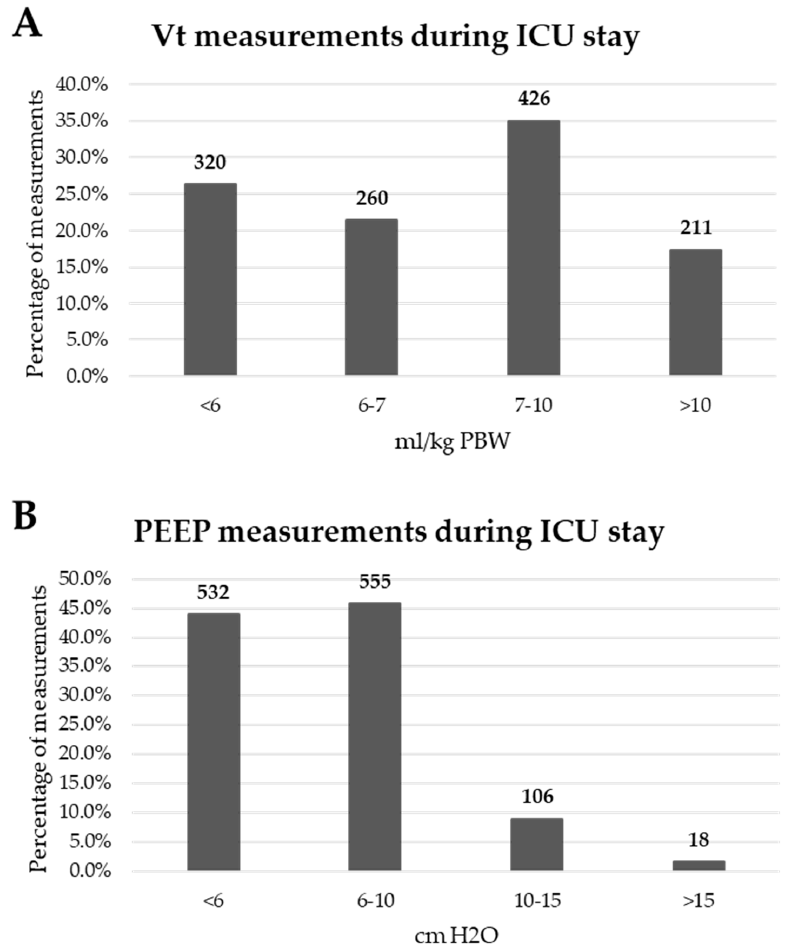
Figure 2. ( A ) V T measurements during the whole ICU stay. ( B ) PEEP measurements during the whole ICU stay. Absolute numbers are shown above the bars.